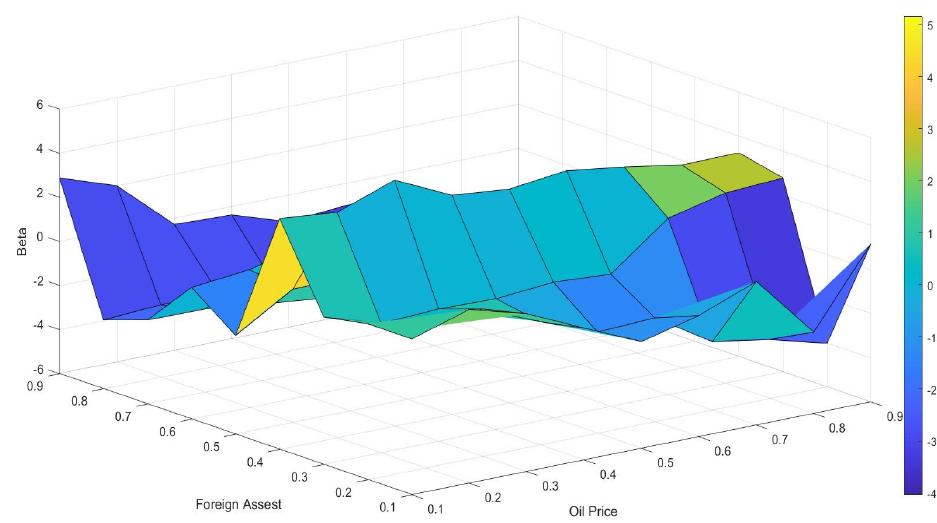
Figure 4. Response of foreign assets to oil price. Monthly data.